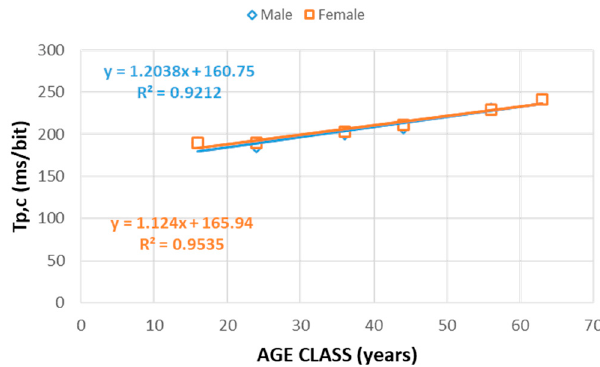
Figure 3. T p,c values vs. age and sex from Equation (9) on the basis of data from [54].